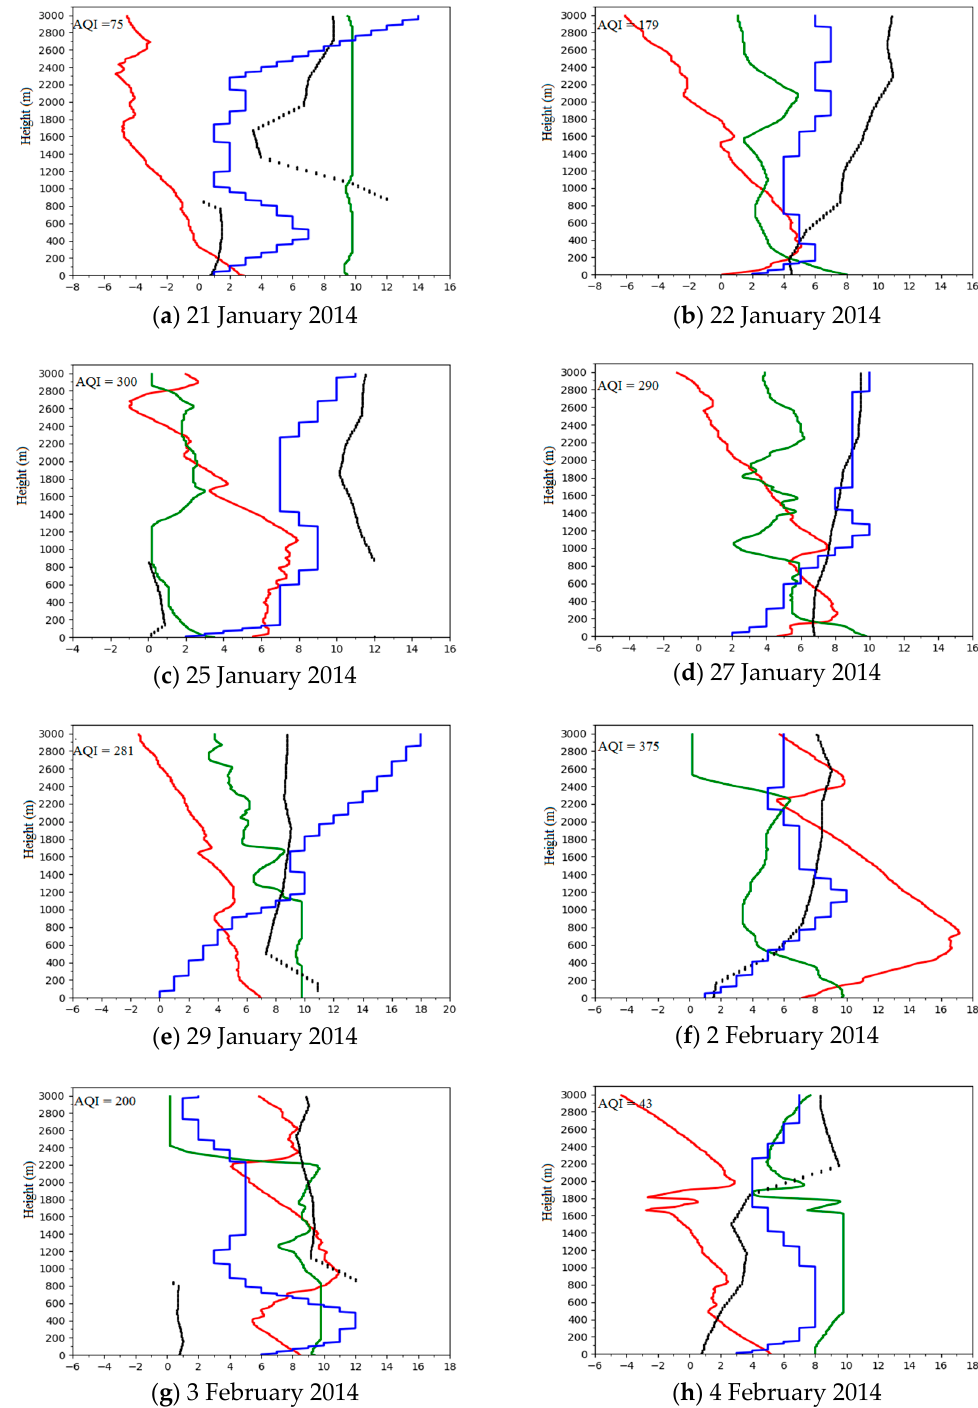
Figure 5. Vertical structure of the atmosphere for ( a ) 21 January 2014, E w = 121.87 J/cm 2 ( b ) 22 January 2014, E w = 51.51 J/cm 2 ( c ) 25 January 2014, E w = 121.87 J/cm 2 ( d ) 27 January 2014, E w = 121.87 J/cm 2 ( e ) 29 January 2014, E w = 121.87 J/cm 2 ( f ) 2 February 2014, E w = 121.87 J/cm 2 ( g ) 3 February 2014, E w = 121.87 J/cm 2 ( h ) 4 February 2014, E w = 121.87 J/cm 2 . The line and scatter points show the profile of temperature (red line, ◦ C), relative humidity (green line, %), wind velocity (blue line, m/s) and wind direction (black scatter plot, ◦ ) for the heavy pollution period (21 January 2014–4 February 2014). The number on the x-axis is the result after dividing the relative humidity value by 10 and wind direction angle by 30 while potential temperature and wind speed remain the same.